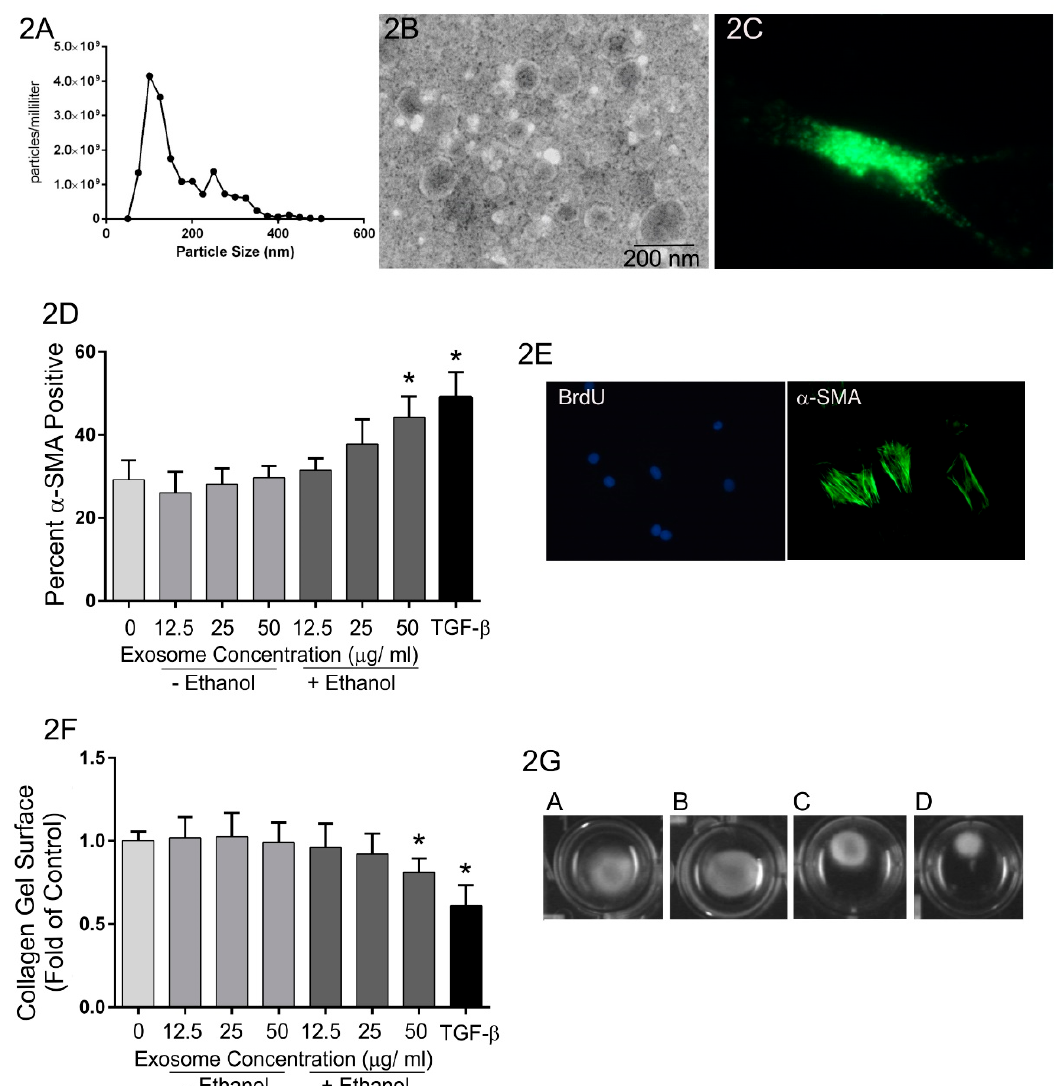
Figure 2. Effects of H9c2 cardiomyocyte-derived exosomes on fibroblast activation. H9c2 cells were treated with 0 or 200 mg/dL ethanol for 24 h, exosomes purified from the conditioned medium and used to treat cardiac fibroblasts. ( A , B ) Purified exosomes were analyzed by NanoSight and transmission electron microscopy illustrating that the majority of the vesicles were less than 200 nm in diameter. ( C ) Purified exosomes were labeled with fluorescent PKH67 and used to treat cultured cardiac fibroblasts. Representative fluorescent microscopy image illustrating abundant PKH67-labeled exosomes associated with a cardiac fibroblast in vitro. ( D ) Quantification of α -smooth muscle actin-positive fibroblasts following treatment with no exosomes (negative control) or varying doses of exosomes isolated from H9c2 cells treated with 0 or 200 mg/dL ethanol. Following purification, the protein concentration of exosomes was determined using the bicinchoninic acid assay (Pierce BCA Protein Assay). The concentrations of exosomes used for treatment of fibroblasts was standardized based upon total protein concentration. TGF- β 1 treatment (5 ng/mL) was included as a positive control. ( E ) Images of control cells illustrating BrdU-positive nuclei used to count total cells and anti- α -smooth muscle actin immunocytochemistry used as a marker of myofibroblast formation. ( F ) Quantification of collagen hydrogel contraction as an indirect bioassay of fibroblast activation following treatment with no exosomes (negative control) or varying doses of exosomes isolated from H9c2 cells treated with 0 or 200 mg/dL ethanol. TGF- β 1 treatment (5 ng/mL) was included as a positive control. ( G ) Representative collagen gels following treatment for 24 h with: ( A ) no exosomes, ( B ) 50 µ g/mL exosomes from H9c2 cells not exposed to ethanol, ( C ) 50 µ g/mL exosomes from H9c2 cells treated with 200 mg/dL ethanol and ( D ) TGF- β . (* ≤ 0.05 compared with untreated controls based upon One way ANOVA, n = 4 independent experiments including independent fibroblast cultures and independent isolations of